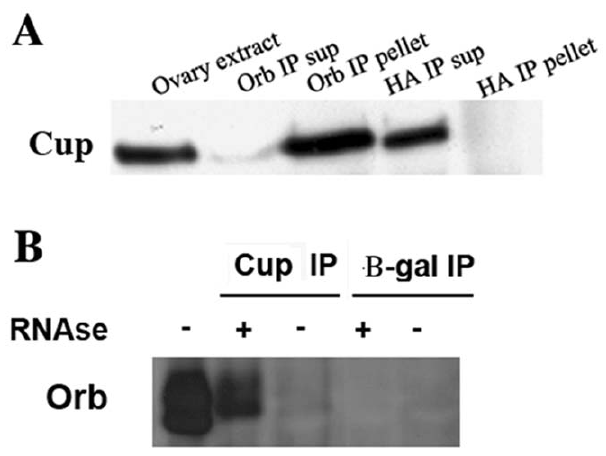
Figure 1. Cup associates with Orb in vivo and affects the phosphorylation status of Orb. Cup was initially identified as an Orb associated protein by analyzing Orb antibody immunoprecipitates from wild type ovaries using MudPIT mass spectrometry [19]. Western blots were used to confirm this association. (A): Immunoprecipitation of ovarian extracts with Orb antibody co-immunoprecipitates Cup protein. Cup does not co-immunoprecipitate with a negative control, HA antibody. The amount of ovary extract loaded in panel A represents 5% of the ovary extract used in the Orb and HA antibody immunoprecip- itates. Half of the sample recovered in each immunoprecipitate was loaded on to the ‘‘pellet’’ lanes. For HA, approximately 2.5% of the sample was loaded into the ‘‘supernatant’’ lane. For the Orb ‘‘supernatant’’ lane a portion of the sample was lost during loading. (B): The converse immunoprecipitation, using antibody against Cup, pulled down both Orb isoform, whereas b -galactosidase antibody does not. The Cup-Orb complexes are RNA-independent as they are resistant to treatment with RNAse A. The amount of ovary extract loaded in the first lanes in each panel consist of 10% of the amount of ovary extracts used in each immunoprecipitation experiment loaded in subsequent lanes. The sample loaded onto the HA ‘‘supernatant’’ lane represents in panel A represents 2.5% of the supernatant from the Cup antibody immunoprecipitation